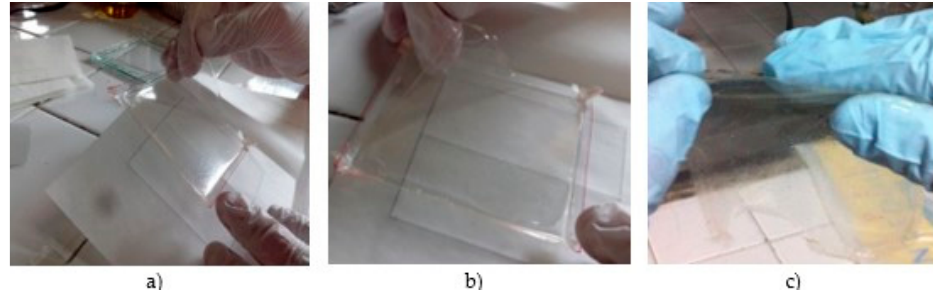
Figure 2. Chitosan films: ( a ) sample 2, ( b ) sample 3 and ( c ) commercial chitosan.